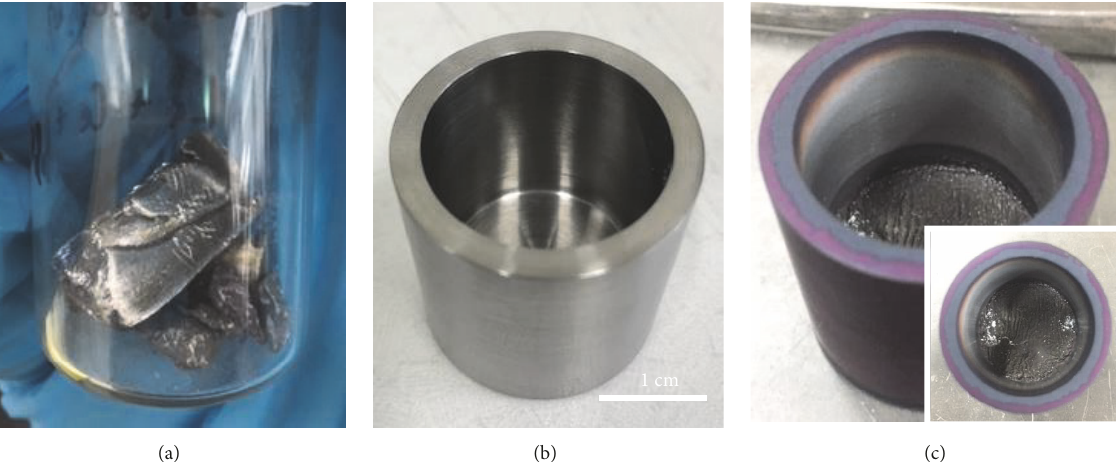
Figure 1: RE metals before (a, b) and after melting test (c); (a) RE metals, (b) W crucible, and (c) molten and resolidified RE metals in crucible.